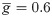
Variance of MLE of N when θ is unknown relative to when it is known, for various sample sizes based on simulation, and asymptotically from Eq (26), where P = 0.1, c = 2 and g¯=0.6.